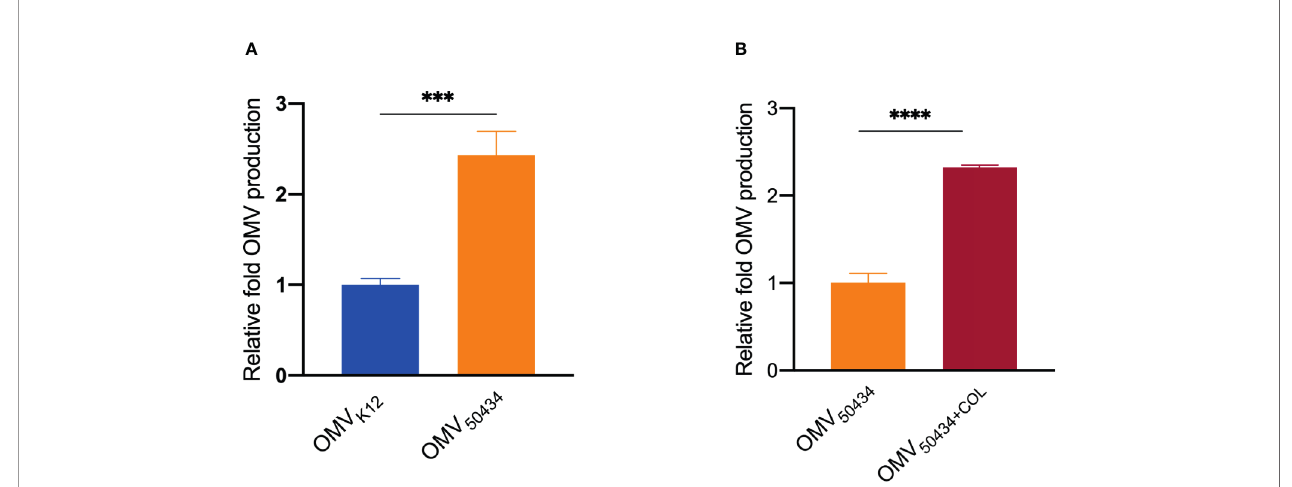
FIGURE 5 | Relative quantitation of OMV production. OMV production was normalized to CFU counts and quantitated for lipid content by FM4-64. (A) The OMV production of E. coli K12 vs E. coli 50434 ( E. coli K12 with mcr-1 ). (B) The OMV production of E. coli 50434 grown with or without colistin (COL, 2 m g/ml). Asterisks (*) denote statistical signi fi cance as determined by unpaired t-test (*** P < 0.001, **** P < 0.0001, n = 3, bars represent mean ±